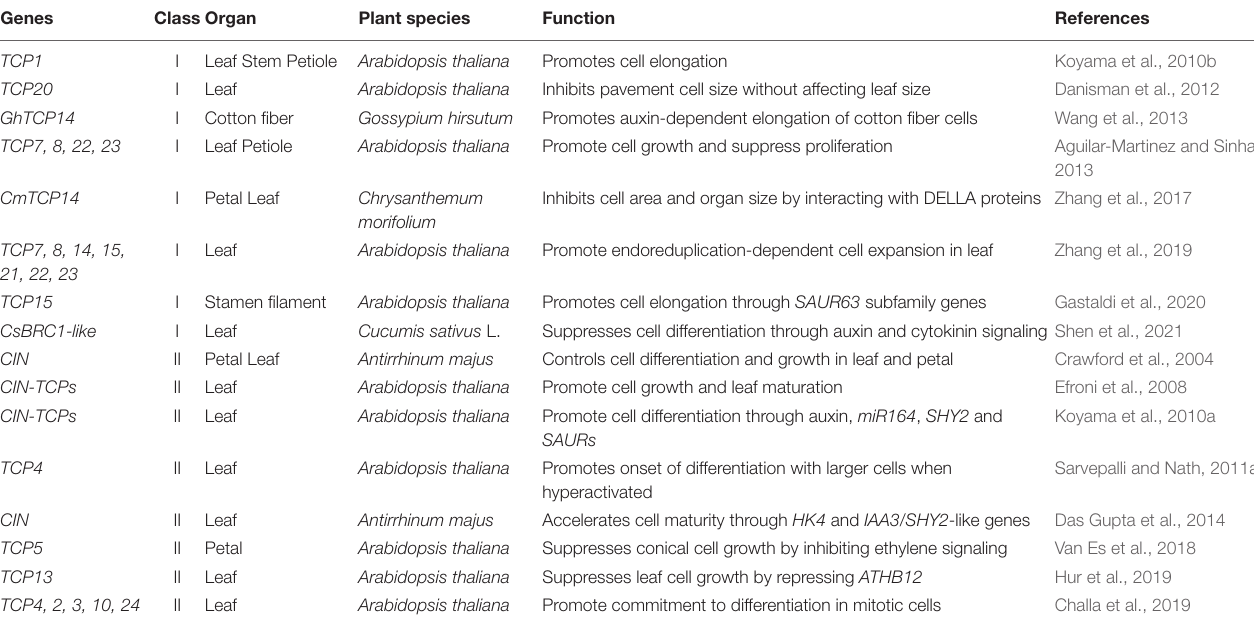
FIGURE 2 | (A) A schematic to describe the correlation between CIN-TCP activity and cell growth in embryonic and post-embryonic organs. Red and green shades indicate progressively higher and lower CIN-TCP levels, respectively, compared to wild-type level in the middle. Height of the gray-shaded objects corresponds to the extent of phenotype indicated on the right. Organs with embryonic origin such as cotyledons and hypocotyl where cell division and expansion are temporally exclusive, exhibit cell expansion directly proportional to CIN-TCP level. In post-embryonic lateral organs such as leaves and petals where cell division and expansion are contemporary, the correlation of cell growth and CIN-TCP abundance is more complex due to combined action of proliferation and expansion. (B) A schematic describing the correlation of GRF activity and cell number and size in leaf. TABLE 2 | TCP genes associated with post-mitotic cell growth in lateral